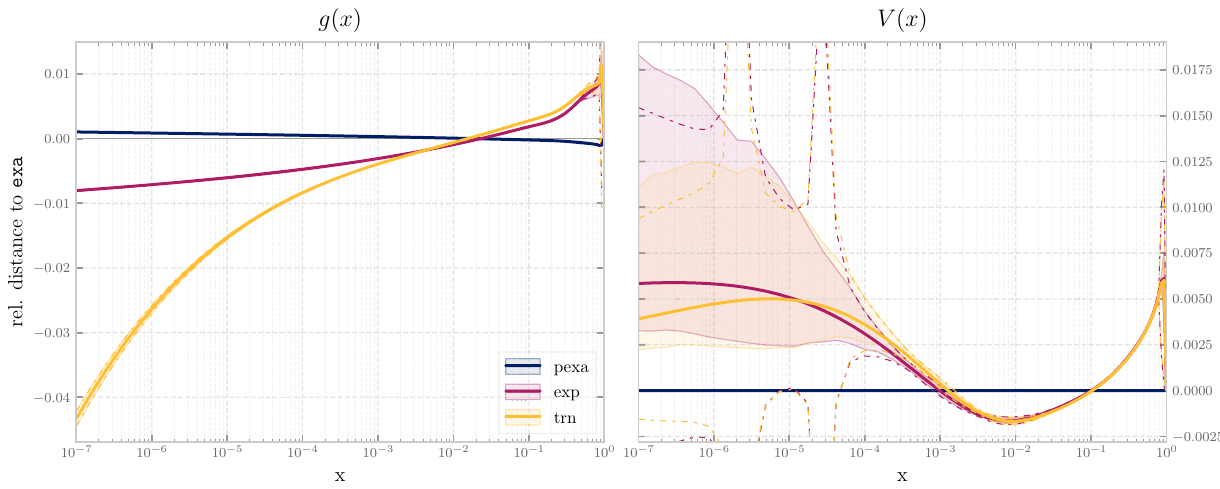
Fig. 4 Compare selected solutions strategies, with respect to the iterated-exact (called exa in label) one. In particular: perturbative-exact ( pexa ) (matching the reference in the non-